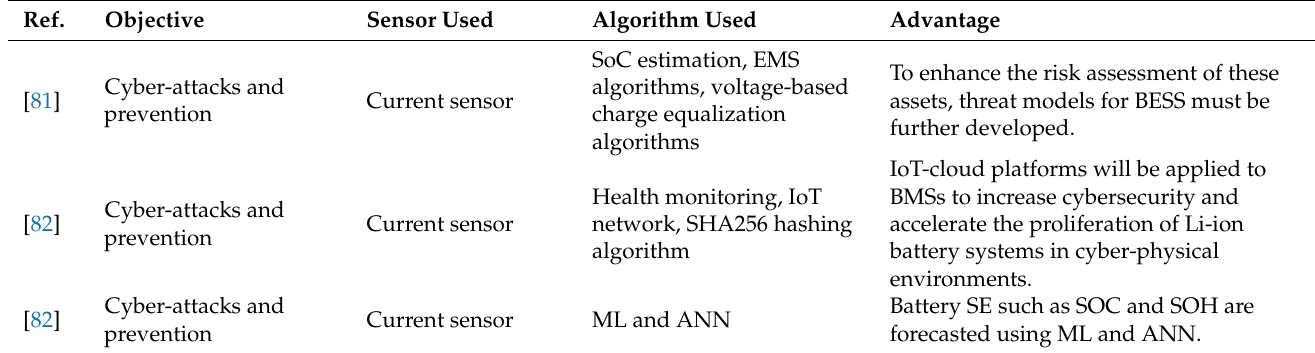
Table 10. A survey on cyber security in